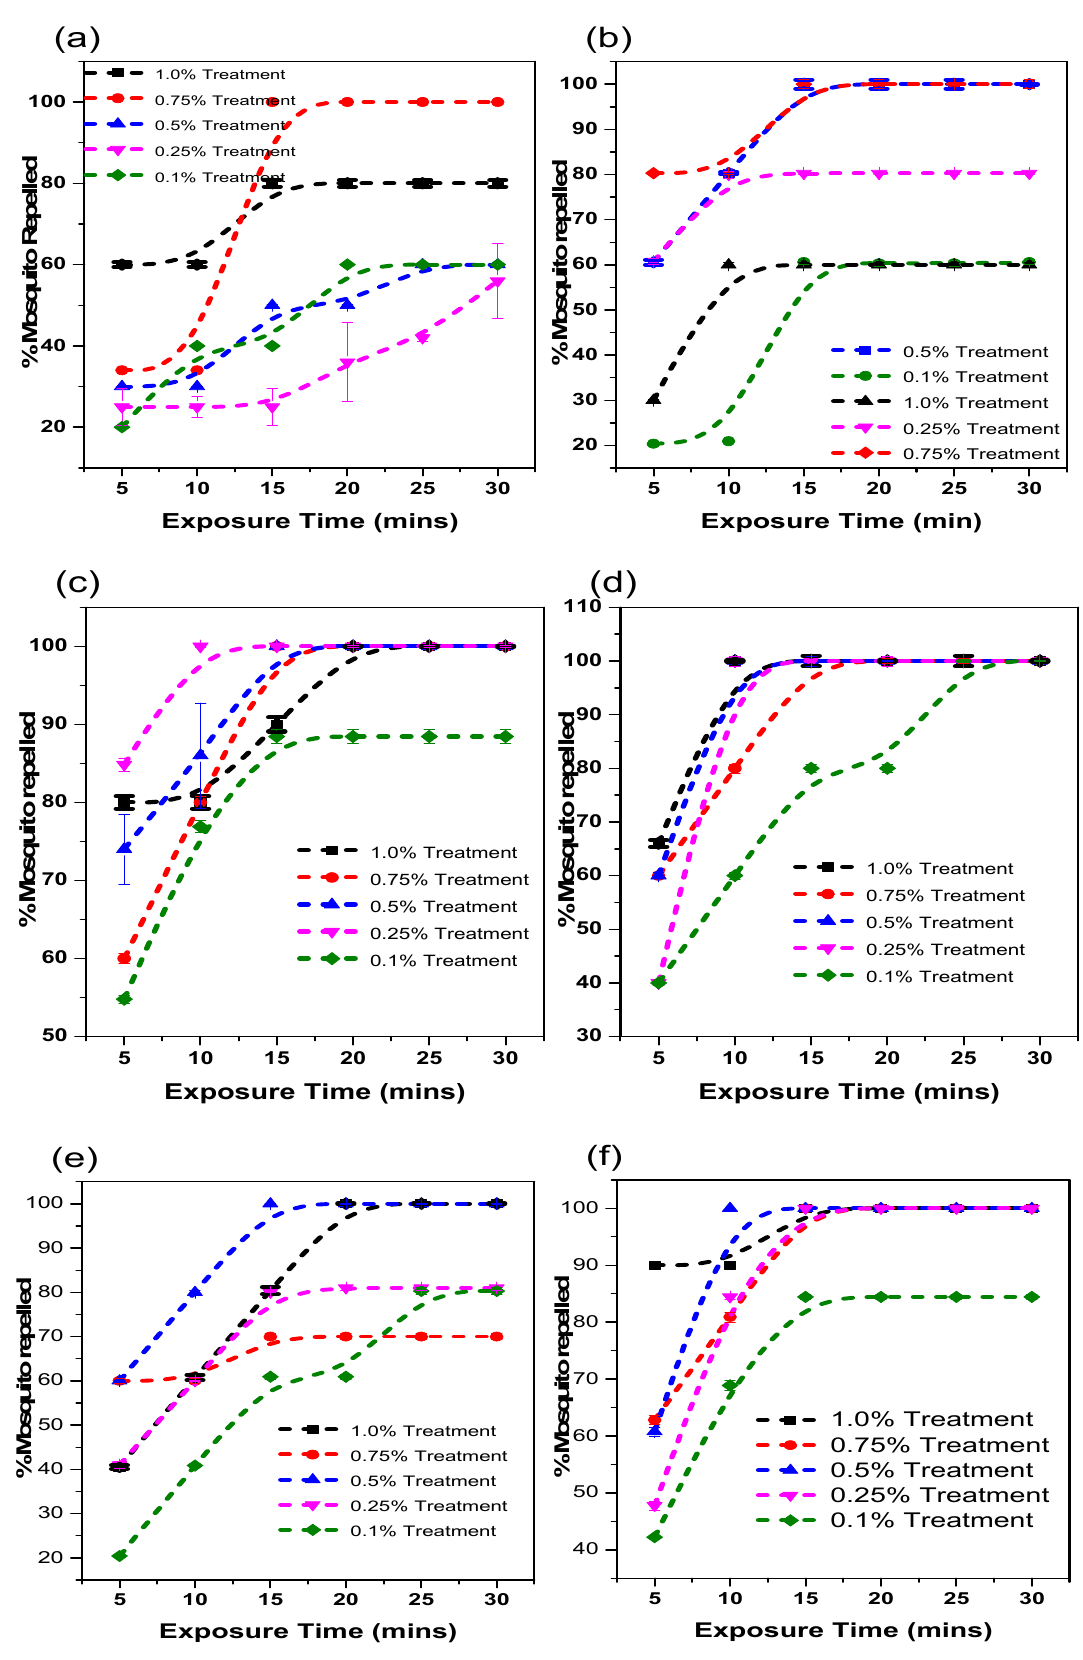
Figure 7. V. negundo essential oil obtained from ( a ) Kogi, ( b ) Benue, ( c ) Niger, ( d ) Nasarawa, ( e ) Plateau, and ( f ) Kwara, % mosquito repellency per 5 min at a 30 min exposure periods.